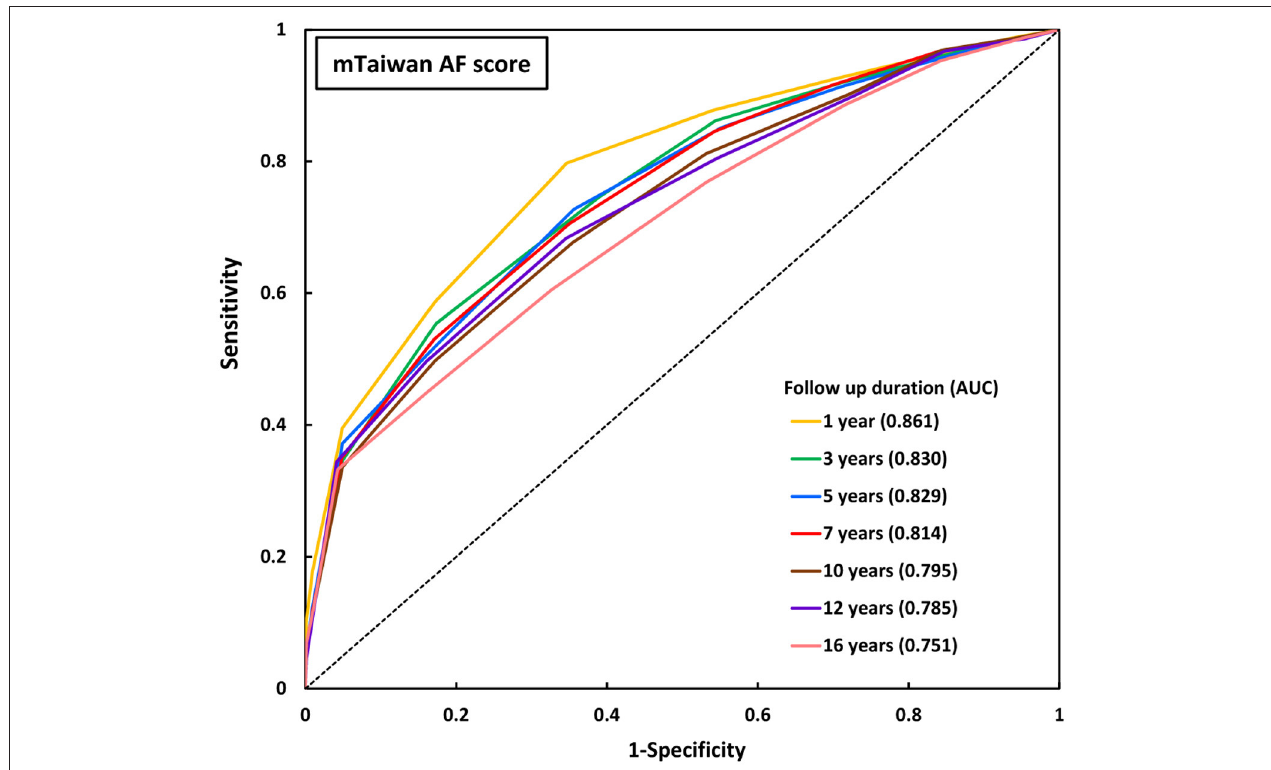
FIGURE 2 | ROC curves of mTaiwan AF score in predicting incident AF. The AUCs of mTaiwan AF score ranged between 0.751 and 0.861 for different follow-up durations. AF, atrial fibrillation; AUC, area under the receiver operating characteristic curve; ROC curve, receiver operating characteristic curve.